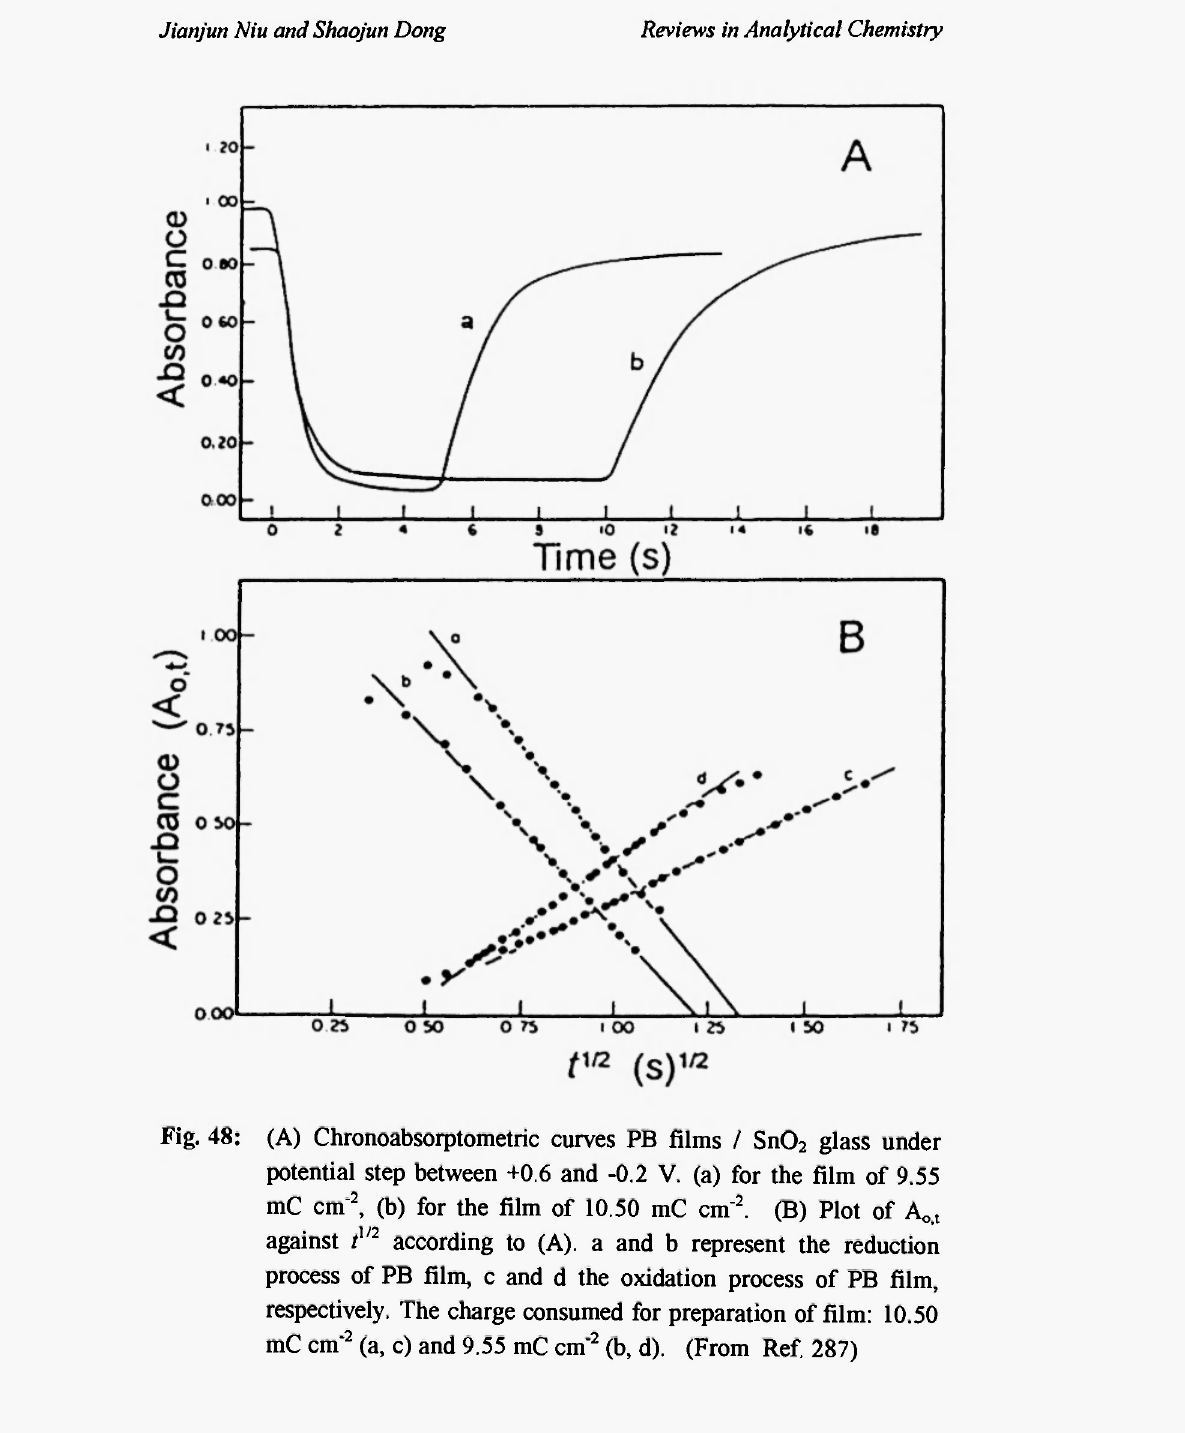
Fig. 48: (A) Chronoabsorptometric curves PB films / Sn0 glass under 2 potential step between +0.6 and -0.2 V. (a) for the film of 9.55 mC cm" 2 , (b) for the film of 10.50 mC cm" 2 . (B) Plot of A«,, against i 1/2 according to (A), a and b represent the reduction process of PB film, c and d the oxidation process of PB film, respectively. The charge consumed for preparation of film: 10.50 mC cm" 2 (a, c) and 9.55 mC cm" 2 (b, d). (From Ref. 287)